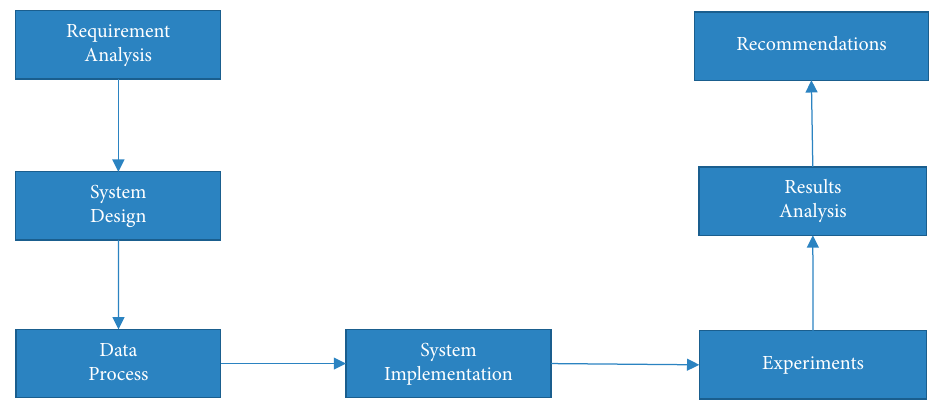
Figure 1: Research